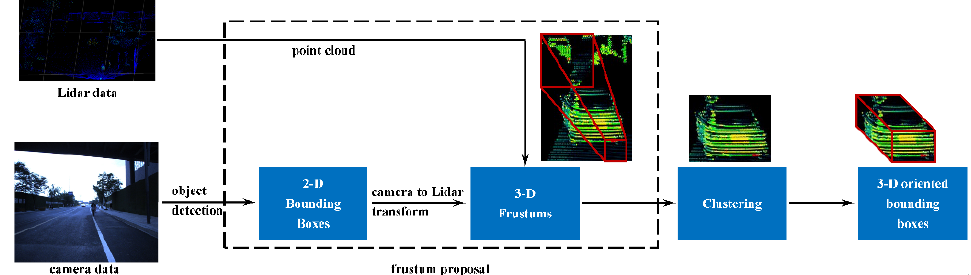
Figure 11. The processing procedure that estimating the depth information of the detected objects from 2D bounding boxes in image.